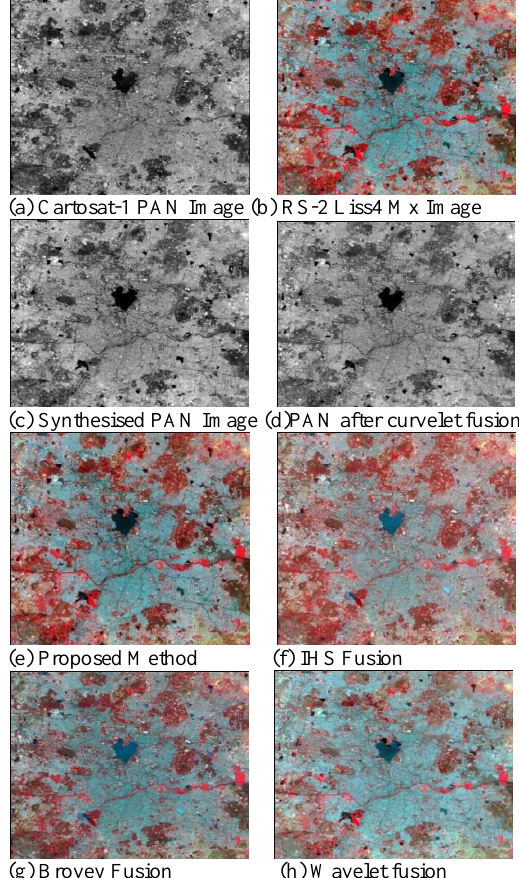
Figure 4: Fused output results of Hyderabad